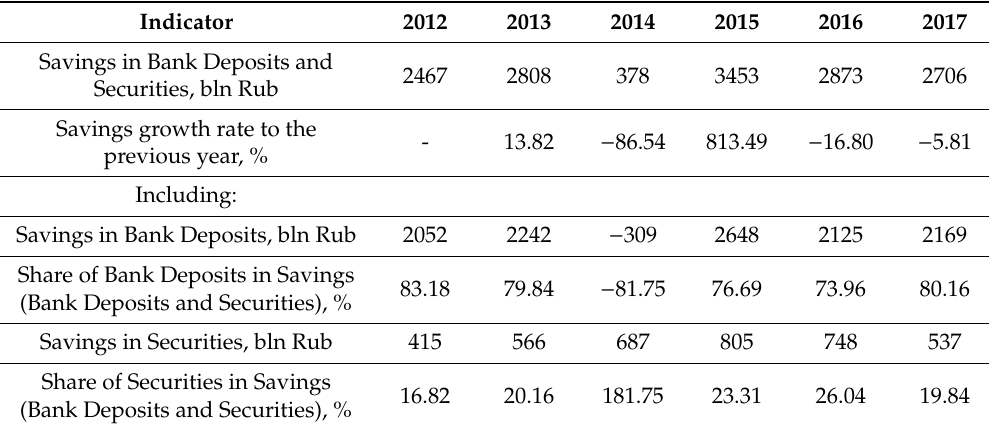
Table 1. Savings of the Russian Federation (RF) Population in Bank Deposits and Securities (per